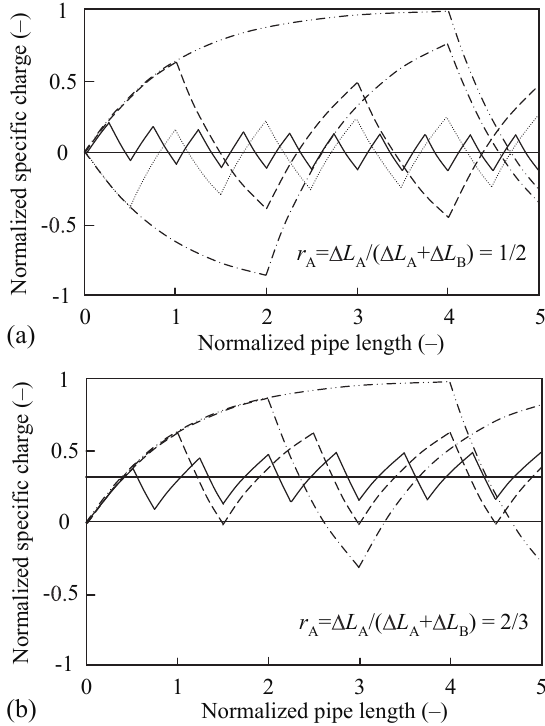
Fig. 4 Normalized calculations of tribocharging in gas–solids pipe flow using two different